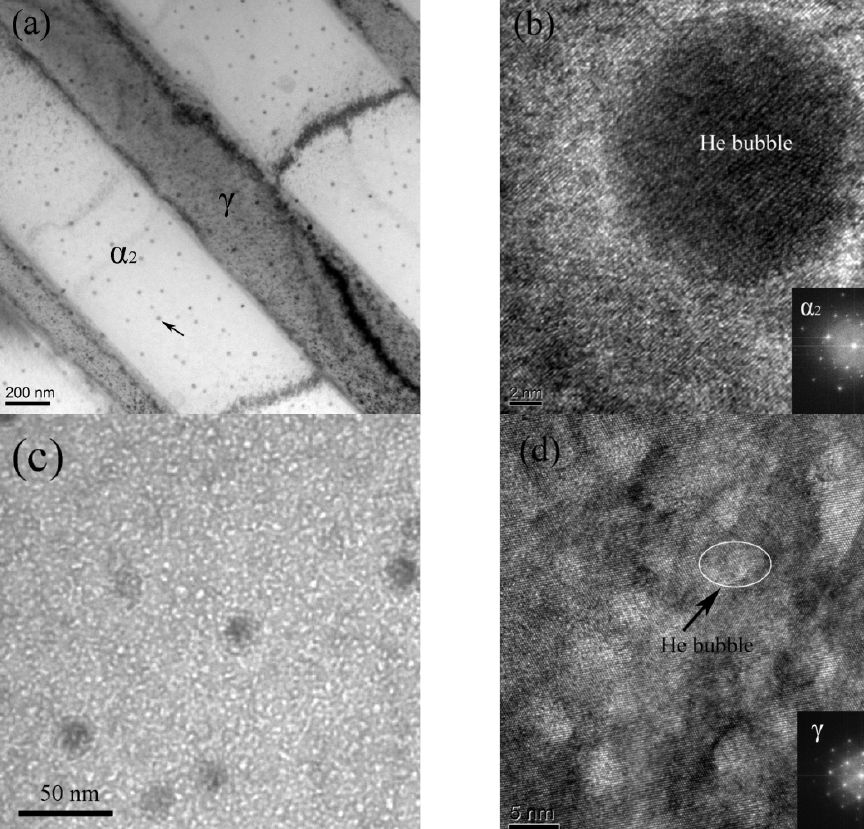
Figure 4. TEM images of the irradiated samples at 773 K with helium ions to a fluence of ( a ) 1 × 10 21 ions/m 2 with the HRTEM images and the corresponding FFT image of the arrow position shown in ( b ), and the γ phase shown in ( c ) with the HRTEM images and the corresponding FFT image shown in ( d ).